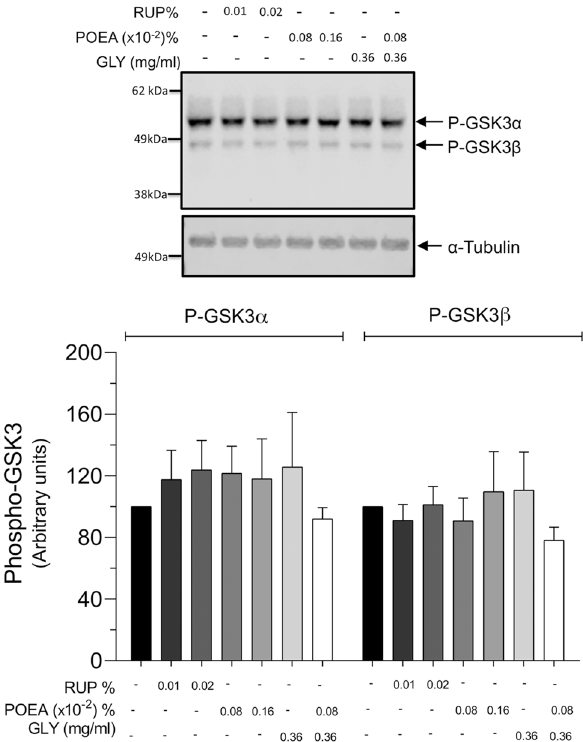
Figure 9. Effects of Roundup Ultra Plus (RUP), glyphosate (GLY) and surfactant polyoxyethylene amine (POEA) in the phosphorylation of GSK3 on human spermatozoa. Spermatozoa were incubated in BWW for 1 h at 37 °C, 5% CO 2 , in the absence or the presence of the herbicide RUP (0.01%, 0.02%) and the equivalent concentrations of its ingredients POEA (0.0008%, 0.0016%), GLY (0.36 mg mL −1 ) or POEA (0.0008%) in combination with GLY (0.36 mg mL −1 ). Upper panel : Human sperm proteins (10 μg) were analyzed by western blotting using anti-phospho-GSK3α/β as primary antibody. Arrows indicate the reactive sperm bands corresponding to phosphorylated forms of GSK3α and GSK3β. Each experiment was performed 6 times (n = 6) and representative films are shown. Loading controls using α-Tubulin antibody (lower film) were performed for each experiment. Lower panel : Densitometry analysis of Phospho-GSK3α and Phospho-GSK3β bands are shown, and values are expressed as the mean ± SEM of arbitrary units. No statistical differences were